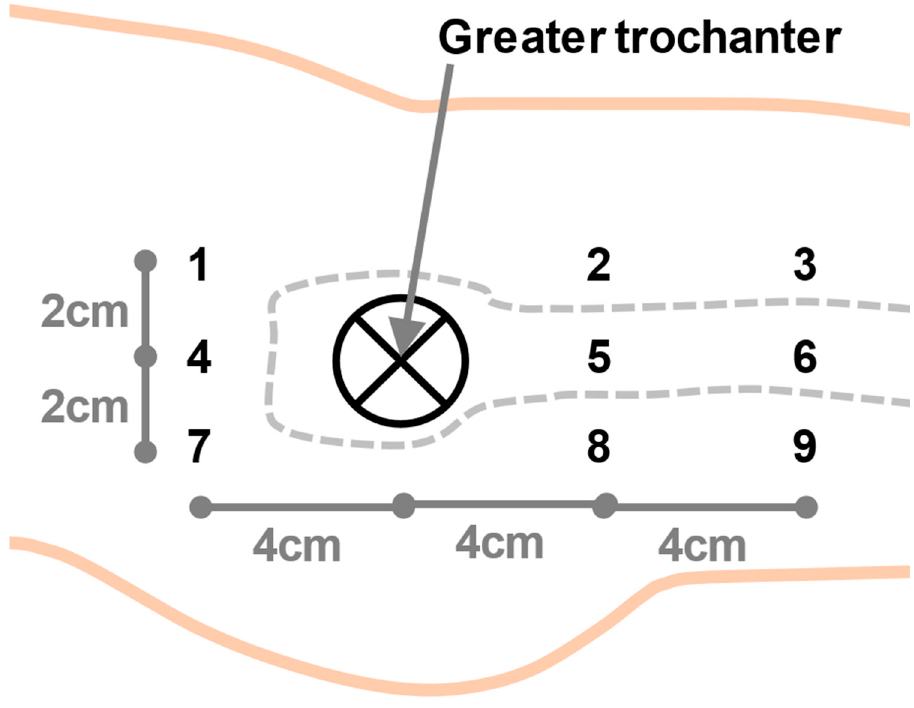
Figure 2. The greater trochanter was used as a landmark to locate the measurement points 1–9.